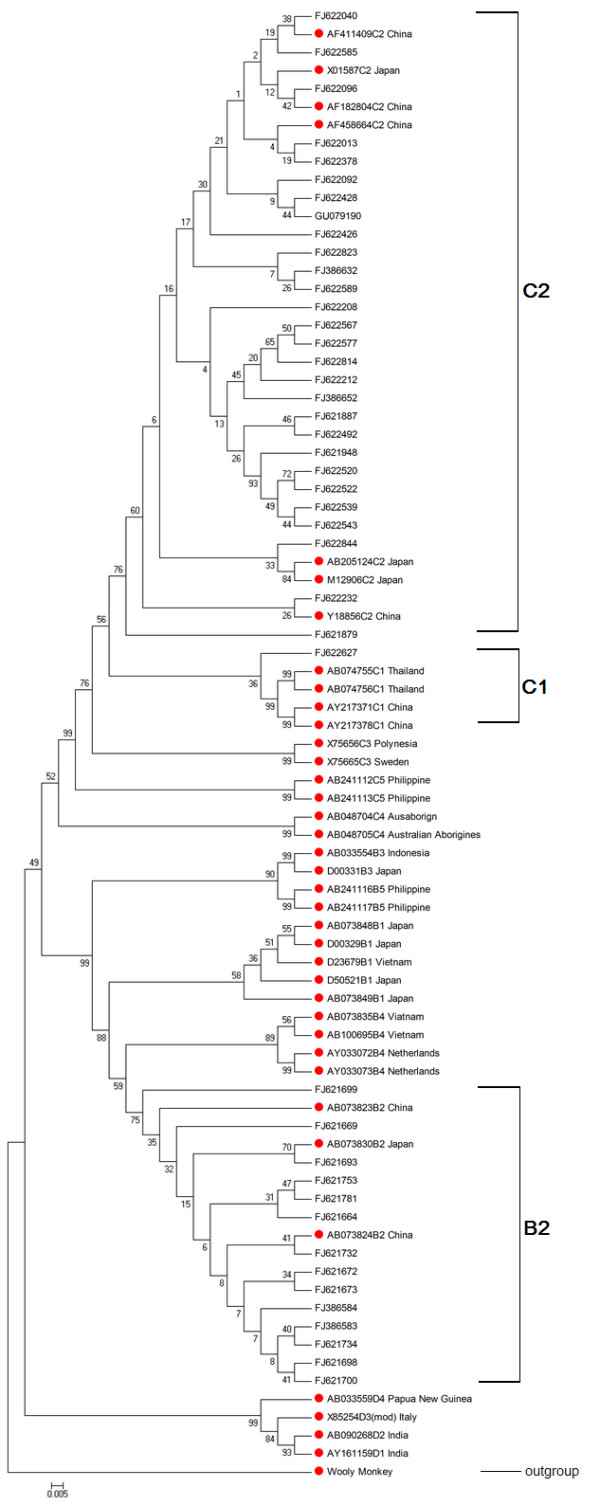
Phylogenetic tree based on 43 representative HBV genetic sequences analyzed with GenBank accession numbers. Standard reference sequences are marked by circles.